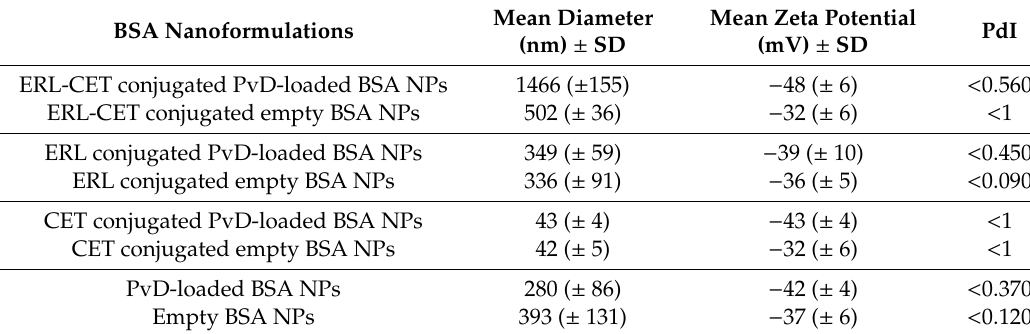
Table 2 . Particle size, polydispersity index (PdI) and zeta potential of all EGFR inhibitors conjugated BSA nanoformulations by DLS analysis.